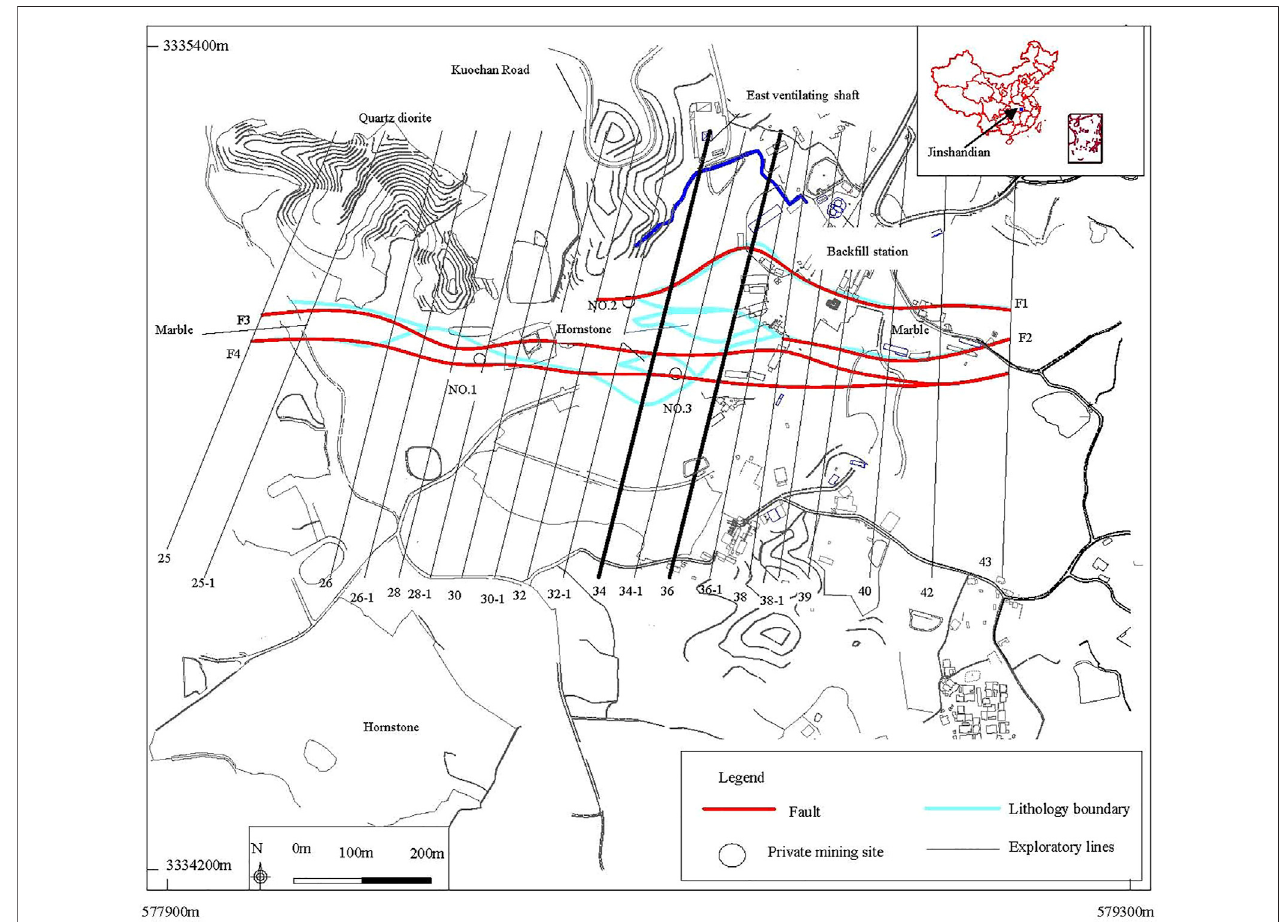
FIGURE 1 | Lithology, faults, and private mining sites in the study